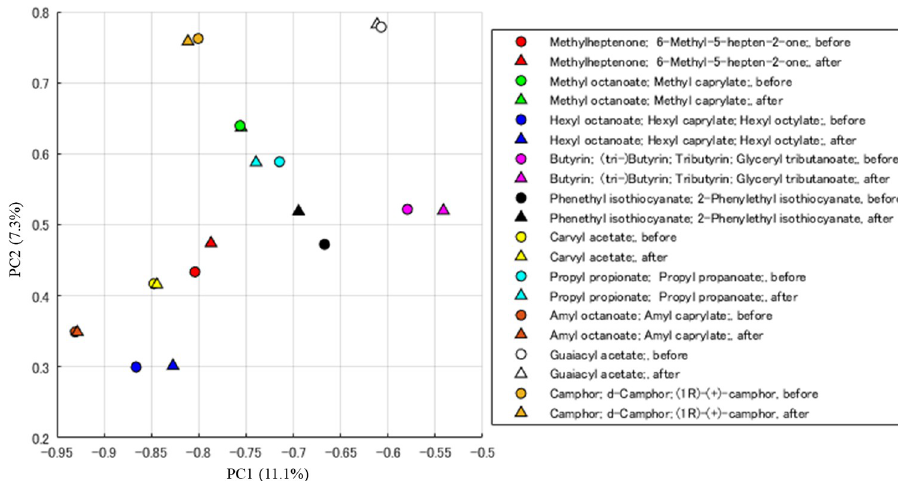
Fig 3. PCA diagram of MS features before and after applying the gradient descent algorithm to the 10 molecules in the DREAM dataset. The circle are mass spectral features obtained by reducing the dimension of the original mass spectra. The triangles are mass spectral features searched by applying the gradient descent method, predicted from odor impression. All plots are obtained using the first and second principal components with proportion of variance.